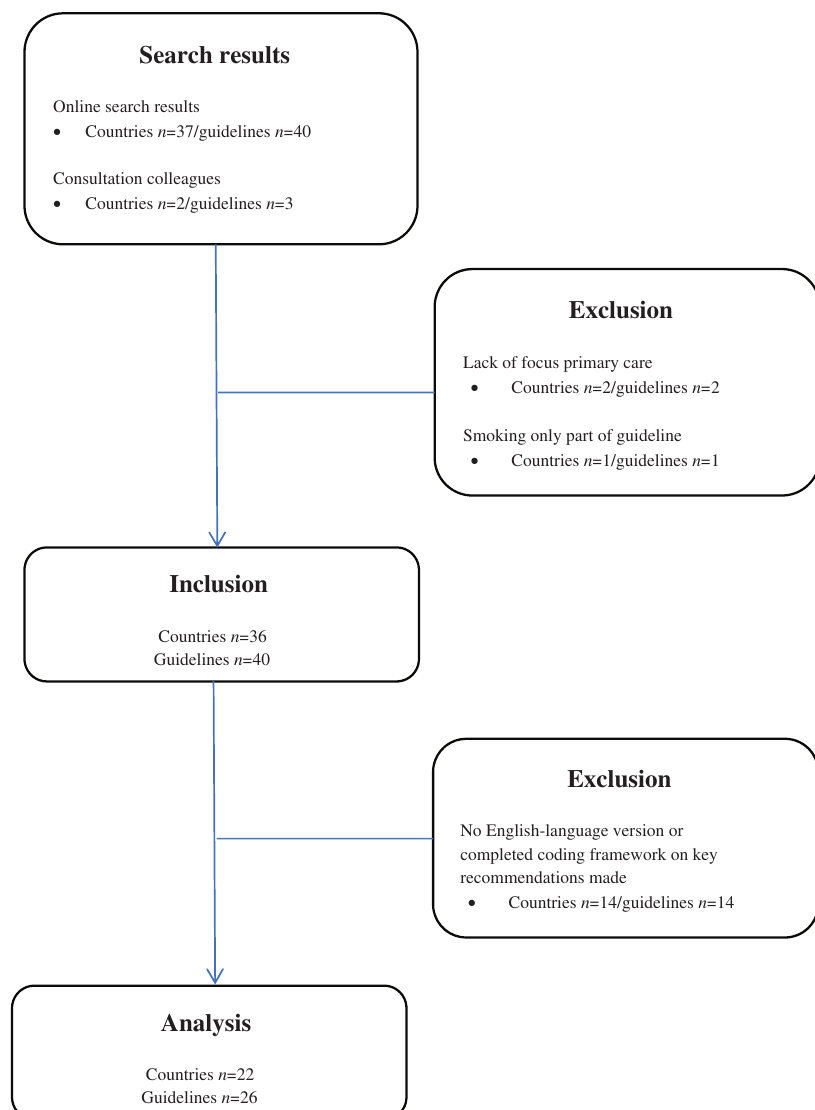
Fig. 1 Flowchart of the